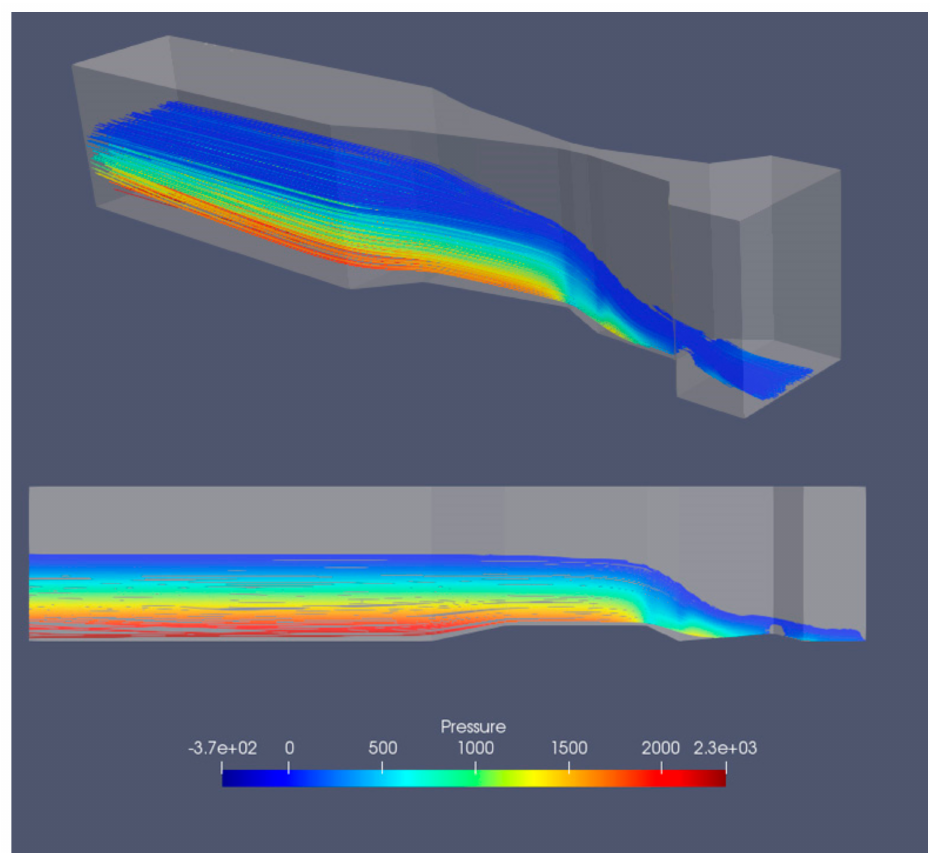
Figure 11. 3D and side view of the pressure field in the flume with a flowrate of 10